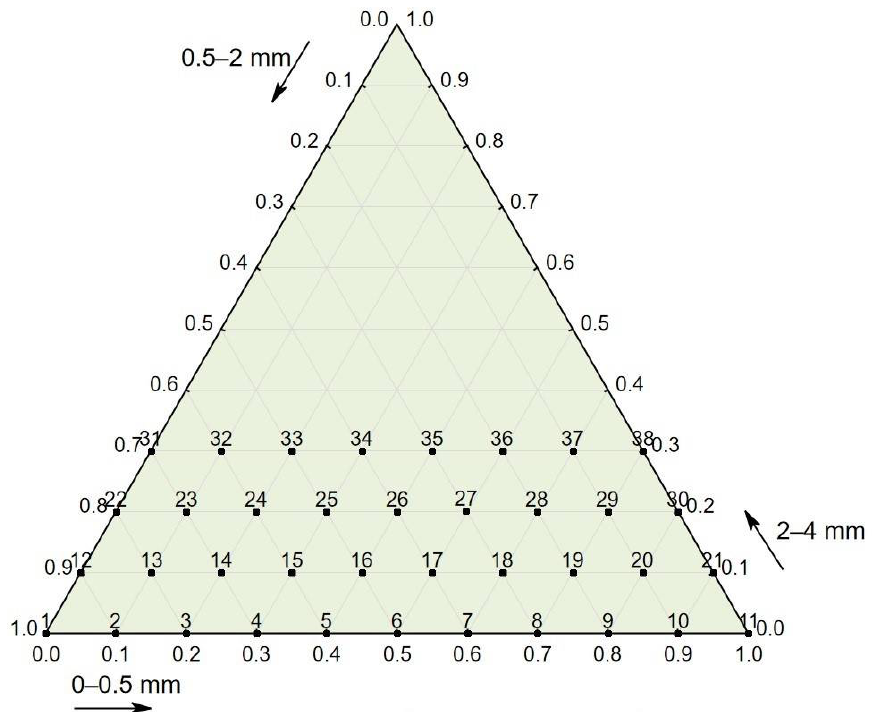
Figure 1. Plan of the experiment: percentage of three aggregate fractions: 0–0.5 mm, 0.5–2 mm, and 2–4 mm for 38 types of tested concrete mixes.